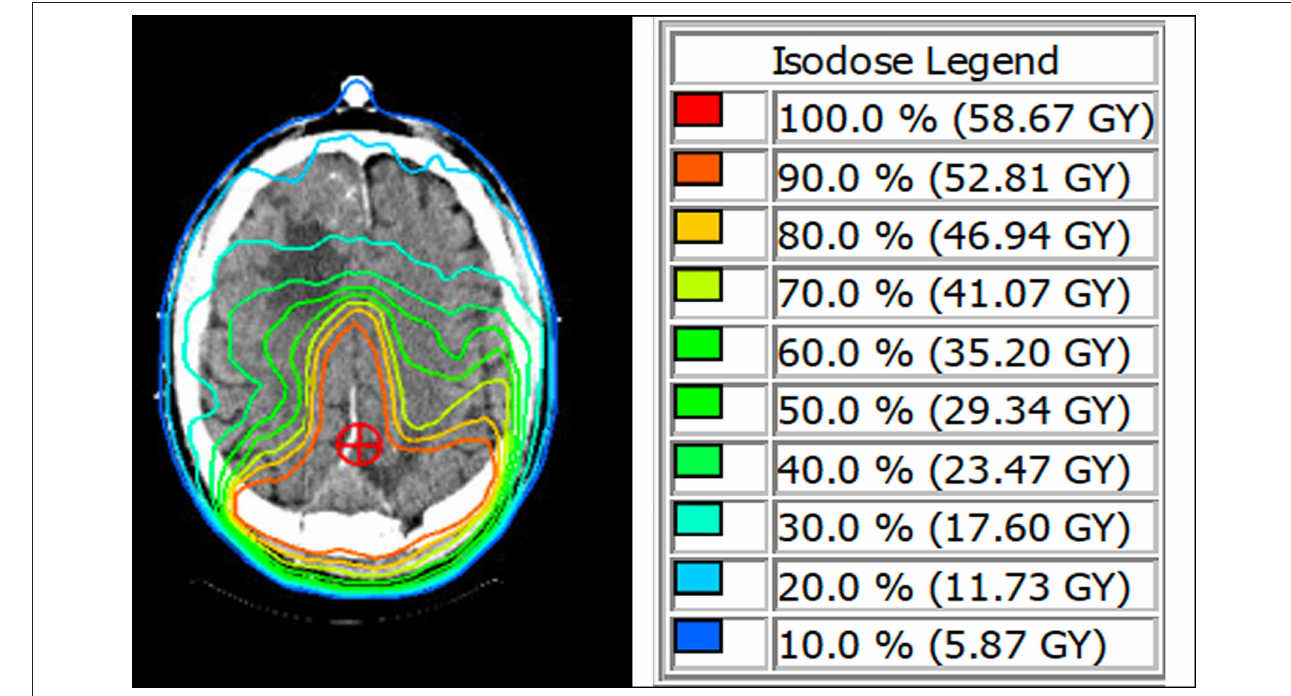
FIGURE 2 | (Left) IMRT treatment planning image. Isodose lines are displayed on post-operative axial CT scan. The targeted total dose (red) is shaped around the remainder of the posterior parasagittal meningioma. The right frontal meningioma can be seen within the lighter blue Isodose line, indicating a potential overall dose between 11.7 and 17.6Gy. (Right) Isodose legend with corresponding percent total planned radiation dose and actual radiation dose to be given over 30